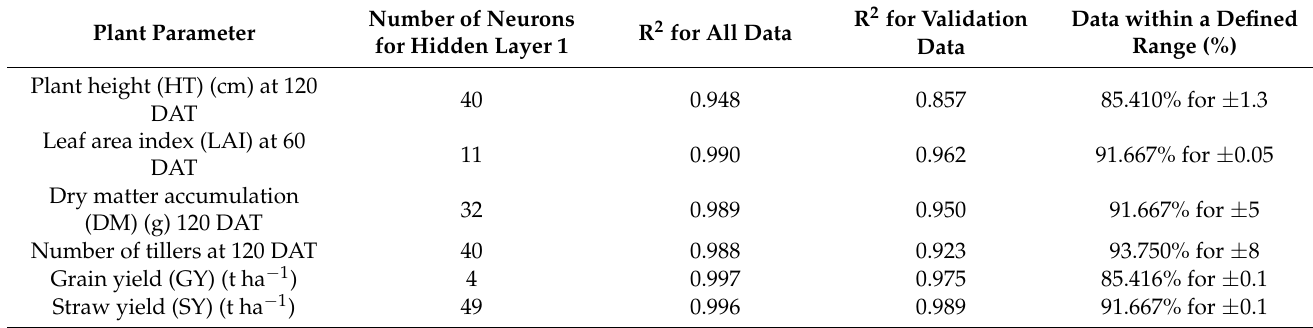
Table 6. The number of neurons in hidden layer 1 and the precision of the